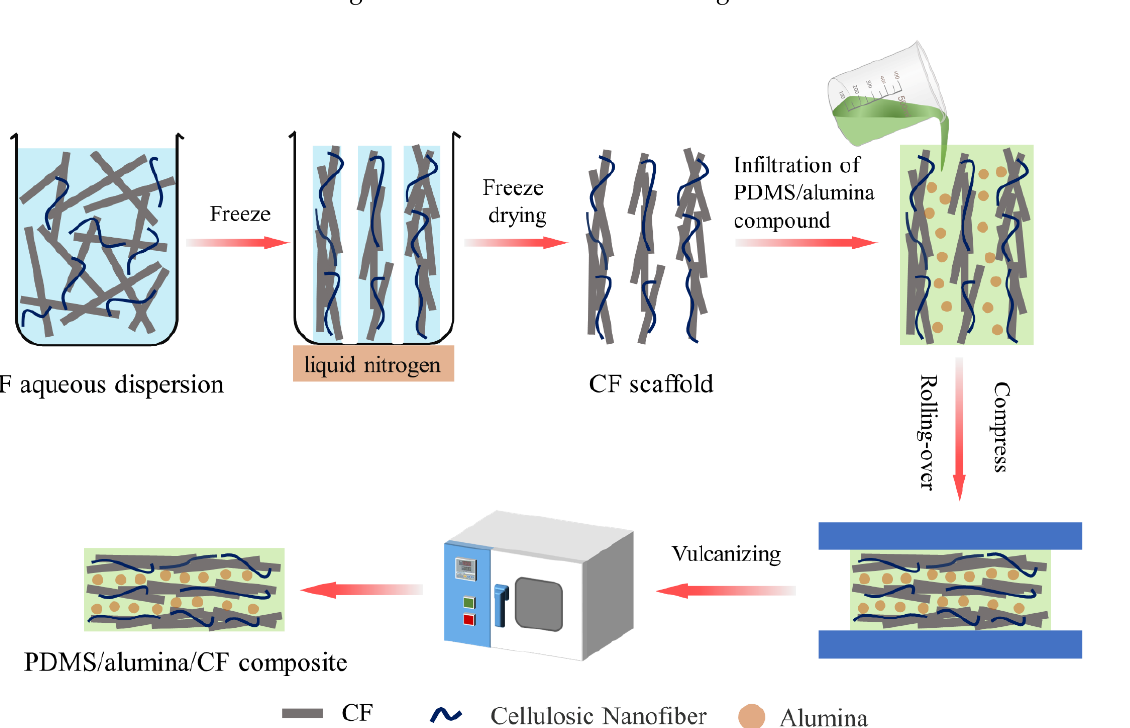
Figure 3. ( a , b ) Fracture surface SEM images of the CF scaffolds with the addition of CMC, ( c , d ) Fracture surface SEM images of the CF scaffolds without CMC. 3.2. Preparation and Characterization of the Horizontally Oriented PDMS/Alumina/CF Composites In order to further improve the orientation degree of the CF and perfect the electrical and thermal conductive pathways, the CF scaffolds were further processed by following these steps. Firstly, alumina and PDMS were mixed to prepare PDMS/alumina